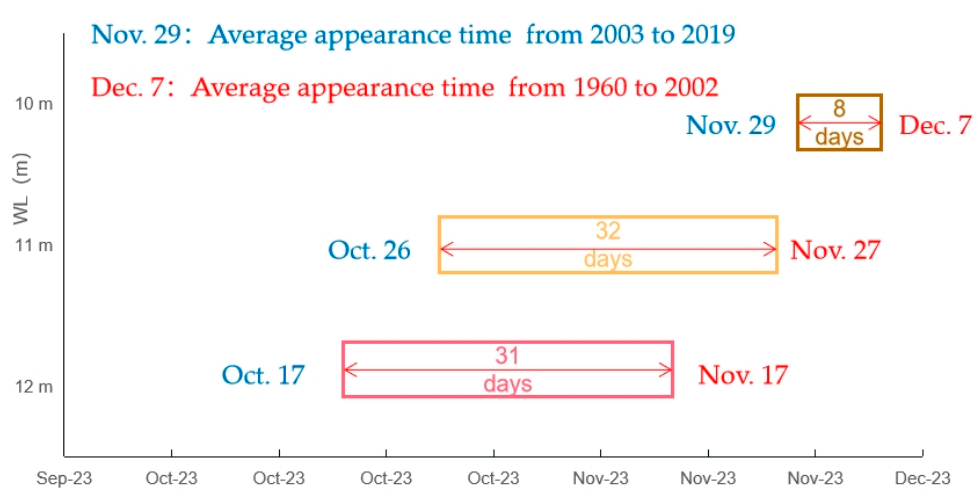
Figure 3. Water level variation and water level curve of the Hukou hydrometric station during the dry season.